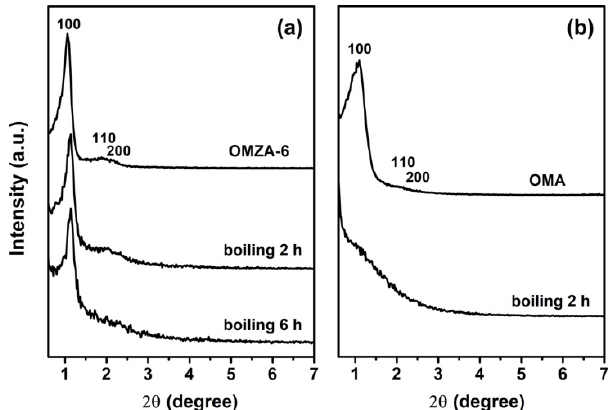
Figure 10. Small-angle XRD patterns of OMZA-6 ( a ) and OMA ( b ) before and after hydrothermal treatment at 100 °C for different time.